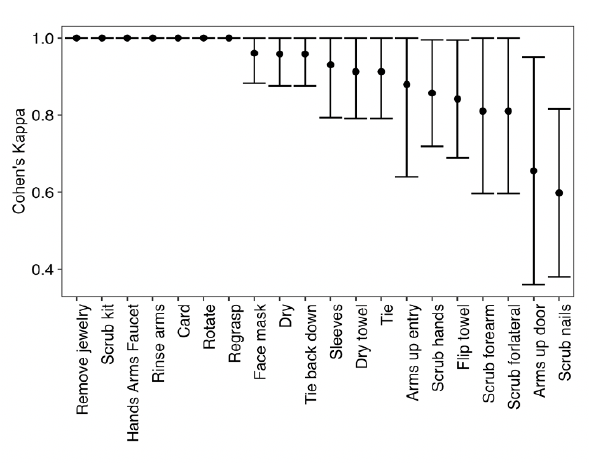
Figure 3 . Cohen’s Kappa ( ) with 95% Confidence Intervals to assess Inter-rater Reliability for each Checklist κ